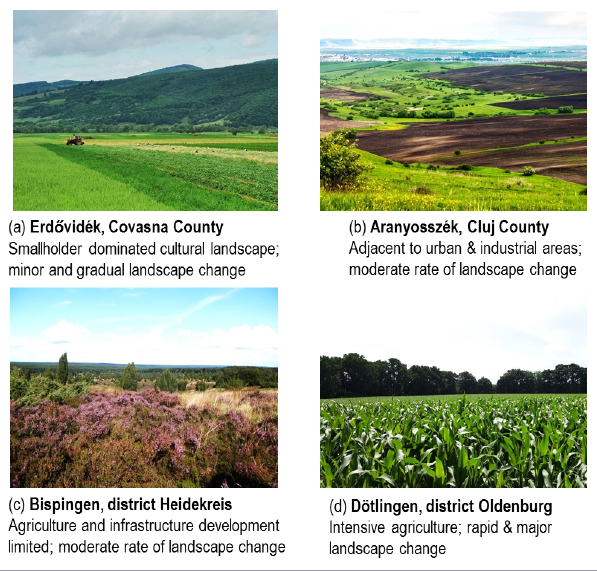
Fig. 1. Example landscape photographs and descriptions of the four focal